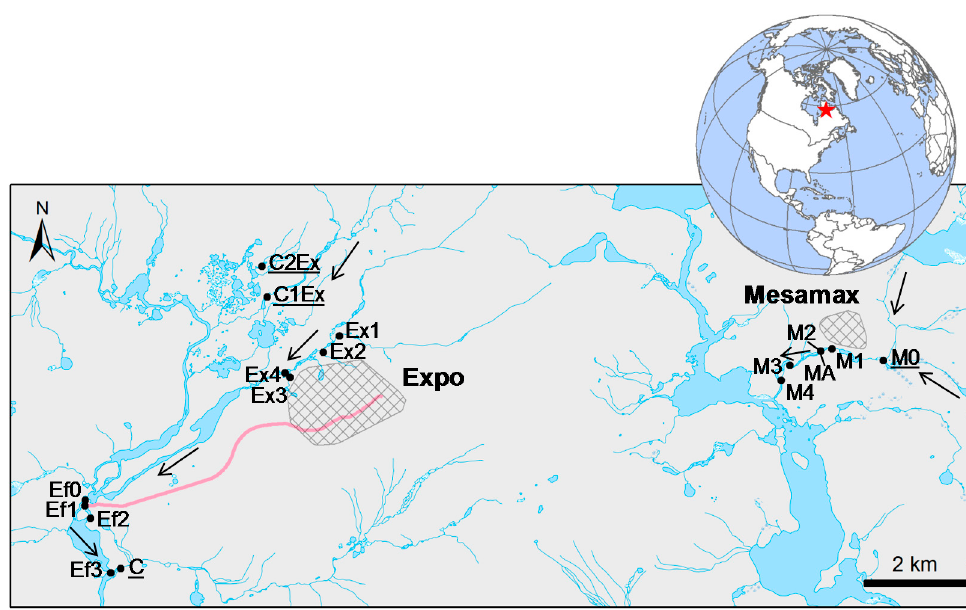
Figure 1. Sampling stations around the Expo and Mesamax mining sites (shaded areas). The treated wastewater effluents from the Expo site are discharged a few km downstream (pink line representing treated sewage pipe). Control stations are underlined.